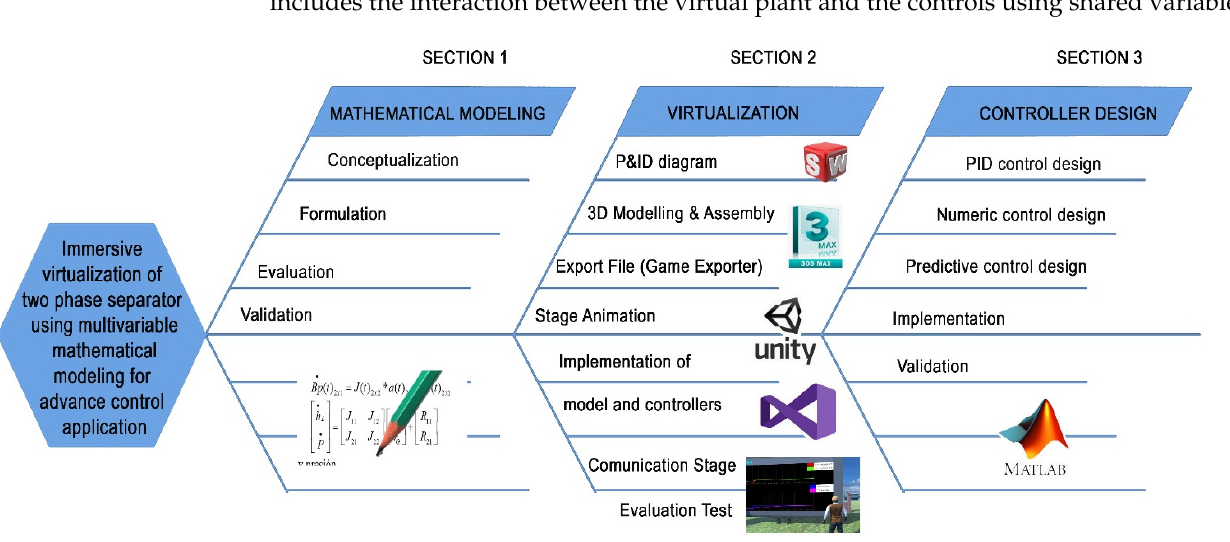
Figure 2. General diagram of the industrial process virtualization